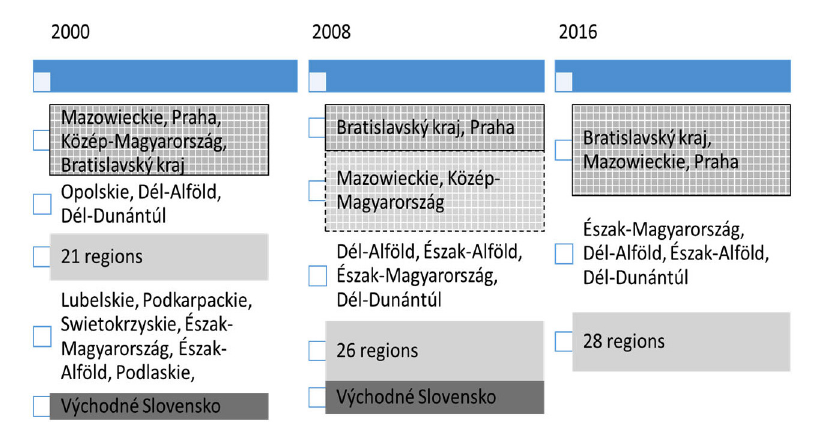
Figure 4. Summary (comparison) of the cluster analysis